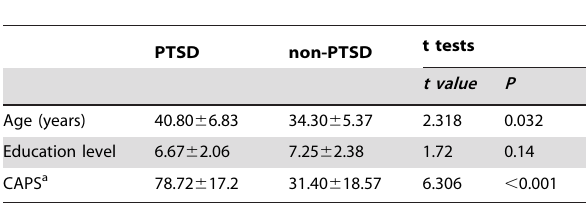
Table 1. Subject physical and clinical characteristics.